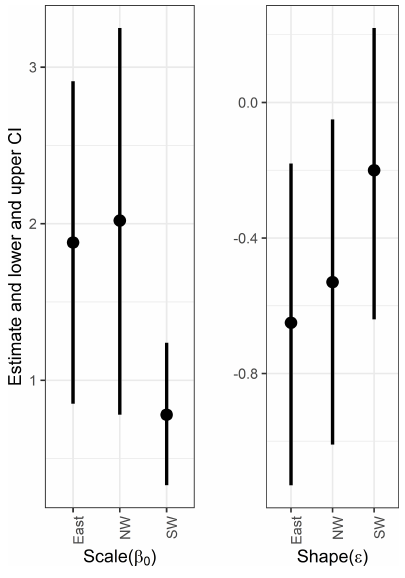
Figure 8. Relationship between precipitation, snow, and reversed reconstructed PDSI values in the northwest based on the best GEV model. Since the PDSI values are reversed, the positive values mean drought conditions. The x axis is precipitation; the y axis is snow; the z axis is reversed reconstructed PDSI values. The left cube (a) is for 10-year events, the central (b) is for 50-year events, and the right (c) is for 100-year events. Since the best GEV model contains precipitation and snow as covariates, the model for the northwest is cubic. This shows that less precipitation leads to higher reversed reconstructed PDSI values, meaning more likelihood of droughts.